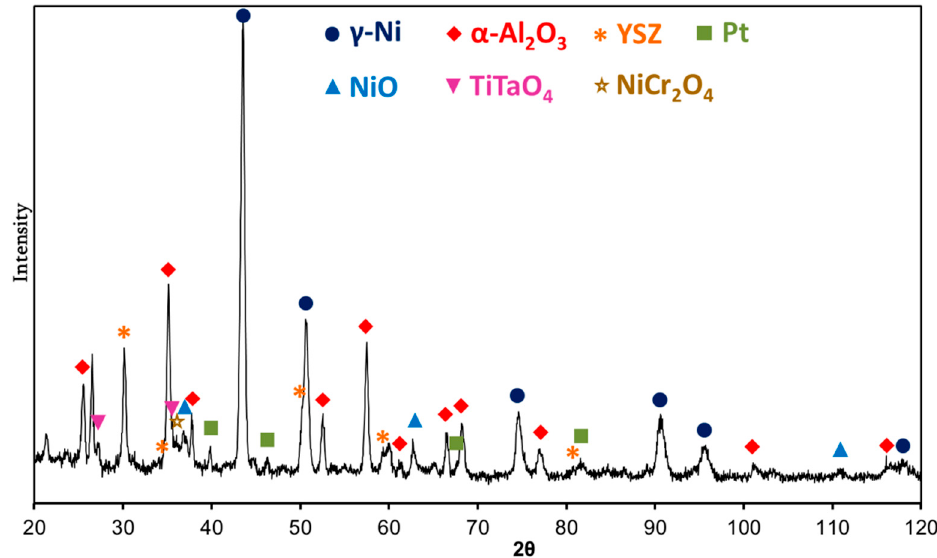
Figure 7. X-ray diffraction (XRD) diagram obtained from the bond-coating surface of the AM3-Trib-Pt/2 TBC system, in the area of catastrophic degradation.